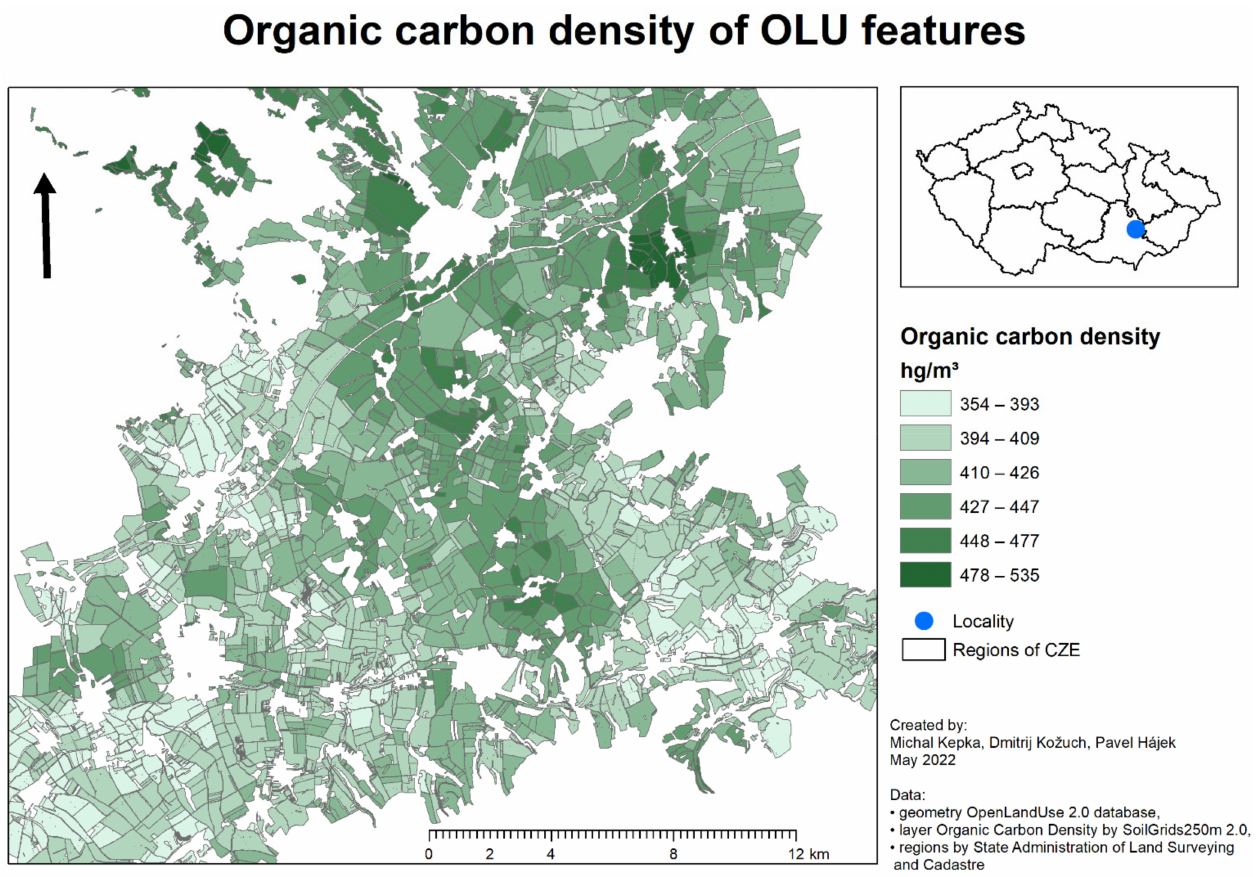
Figure 4. Example of a visualization of the organic carbon density on OLU reference